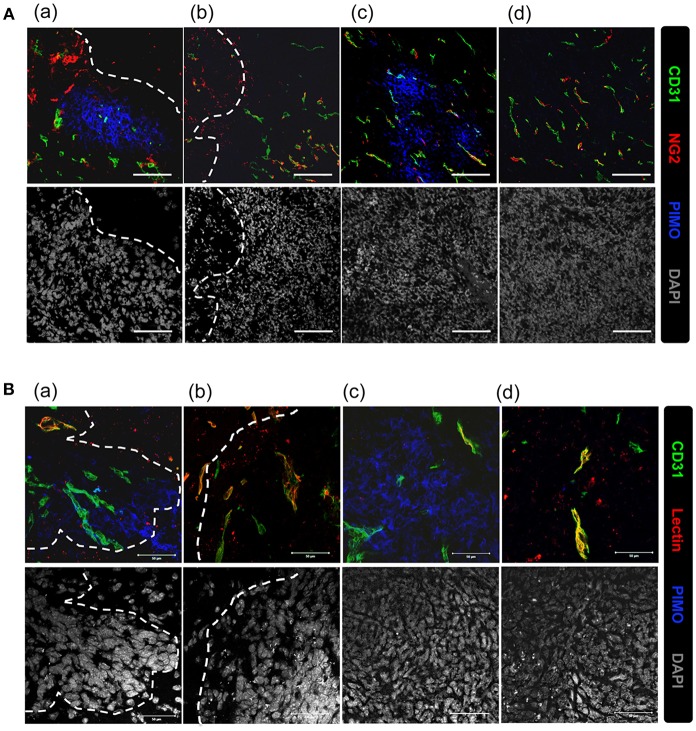
Vascular malfunction, not vascular deficiency, caused the development of peripheral hypoxia. (A) Tumor sections were stained for PIMO (blue), CD31 (green), and pericyte marker, NG2 (red), and captured by confocal microscope. Nucleus was stained by DAPI (gray). Scale bar = 100 μm. (B) Mice were i.v., injected with lectin (red) before sacrifice, and tissues were co-stained with PIMO (blue) and CD31 (green) for examining blood perfusion at tumor core and edge. Nucleus was stained by DAPI (gray). Tumor boundary was outlined by white dotted line. Scale bar = 50 μm.